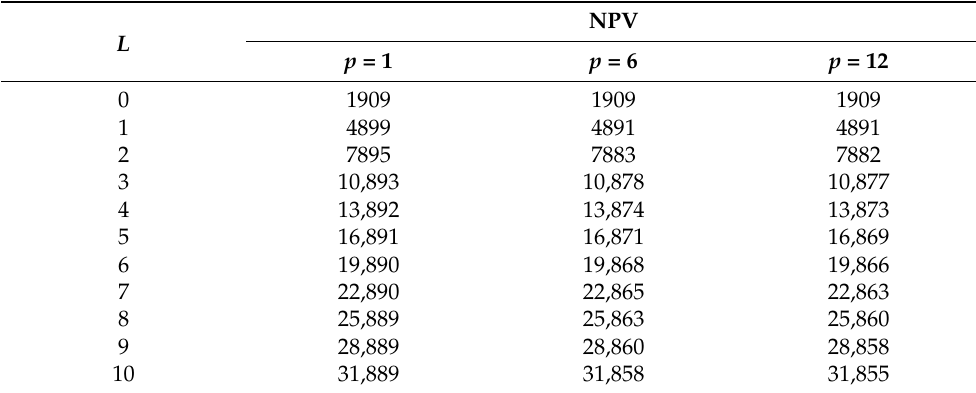
Table 3. Dependence of WACC and NPV on leverage level L at k 0 = 0.22, k d = 0.14 and different p = 1,